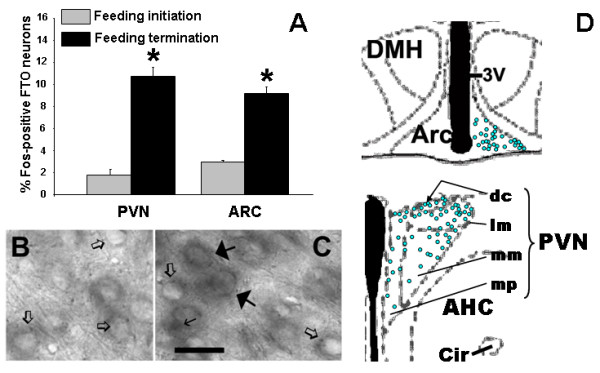
Fos-IR FTO neurons in the PVN and ARC at initiation and termination of feeding. c-Fos was detected by IHC, whereas FTO mRNA by ISH. A. Percentage of Fos-positive FTO cells in the PVN and ARC. B and C. Coronal sections of mice perfused at the beginning and at the end of a meal. Thin arrows, Fos-positive nuclei, thick solid arrows, Fos-positive FTO cells, open arrows, FTO neurons devoid of Fos. Scale bar: 0.02 mm. D. Schematic representation of distribution of Fos-positive FTO cells (each blue point indicates one such cell) in the representative sections encompassing the PVN and ARC. dc, dorsal cap; lm, lateral magnocellular; mm, medial magnocellular; mp, medial parvocellular.